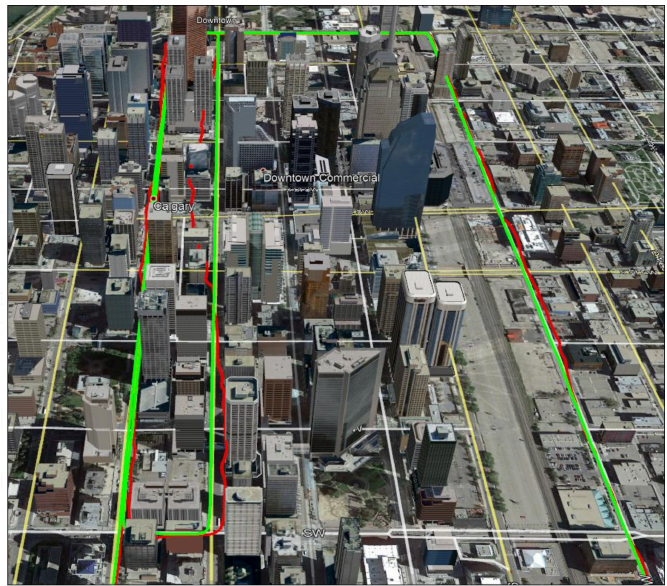
Figure 10. Test trajectory in dense urban environment with the correct reference trajectory (1–2 m accuracy) in green and the GPS trajectory in red. The latter is degraded due to multipath, high measurement noise and poor geometry.